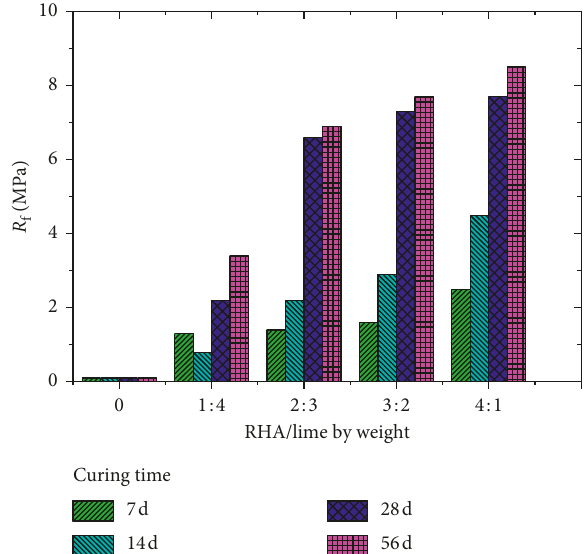
Figure 9: Flexural strength of mortars with different ratio of RHA/